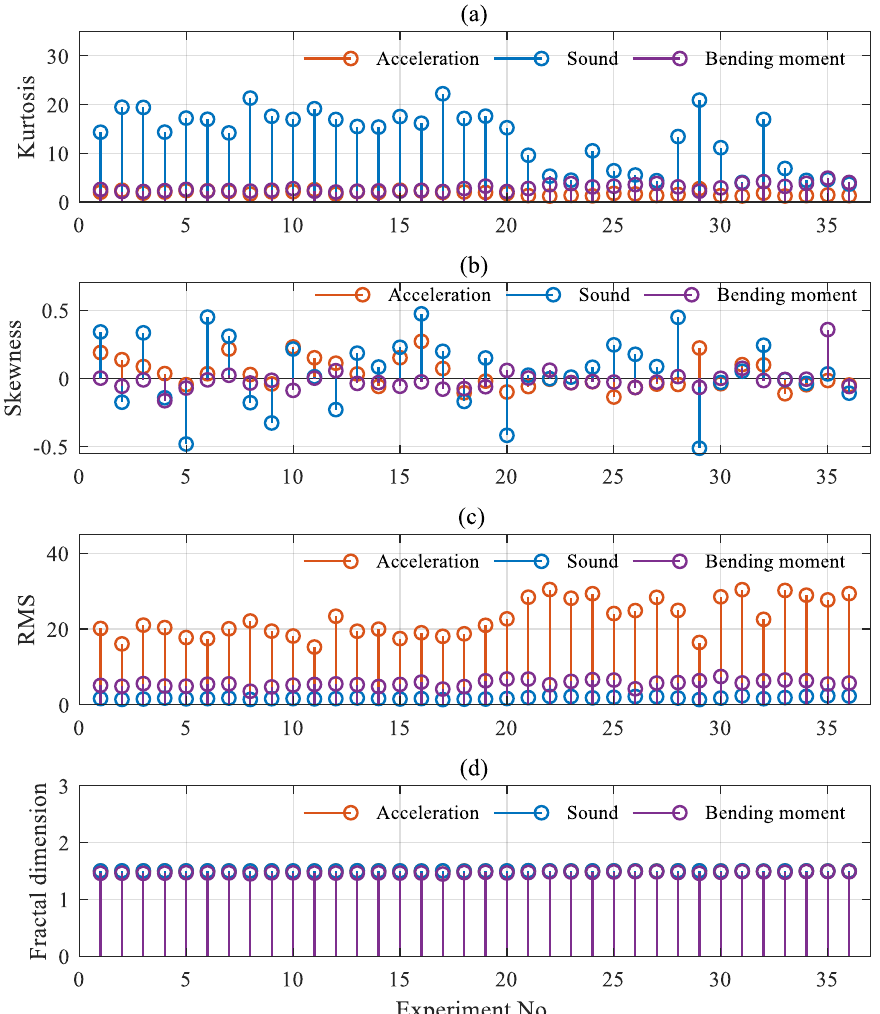
Figure 5. Distribution of features for different process parameters. ( a ) kurtosis; ( b ) skewness; ( c ) RMS; ( d ) fractal dimen- sion.